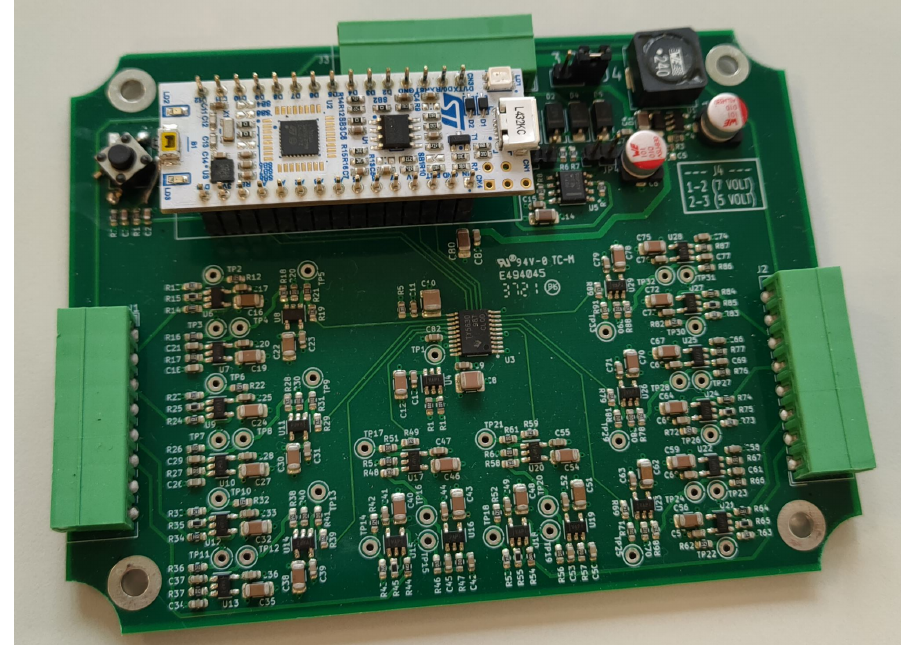
Figure 4. View of the realized RIO board.